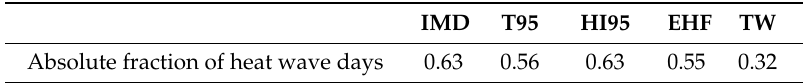
Table 9. Ratio between the number of days identified as heat wave days and the total number of days considered (TW =